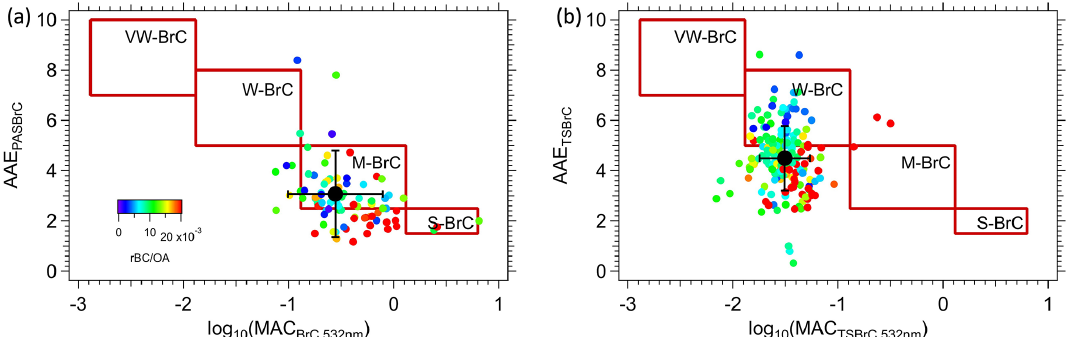
Figure 3. The classification framework proposed by Saleh (2020) with wildfire BrC data inferred or measured during FIREX-AQ by (a) PAS and (b) soluble TS BrC. Each datum is the average of a plume transect for the PAS data, while all filters collected in the smoke are shown. VW-BrC, W-BrC, M-BrC and S-BrC are very weakly, weak, moderately and strongly absorbing BrC. The black with error bars is mean ± SD of the data in each plot.